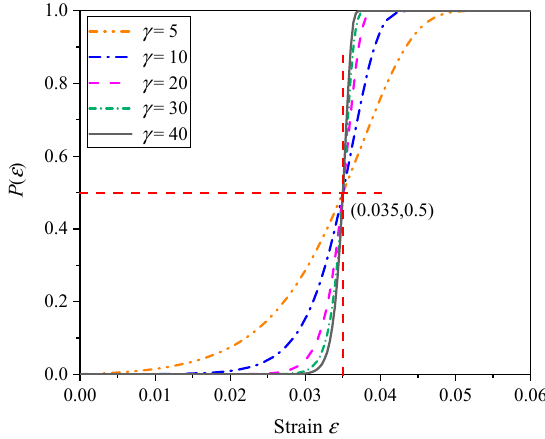
Figure 10. Cumulative failure probability distribution function.